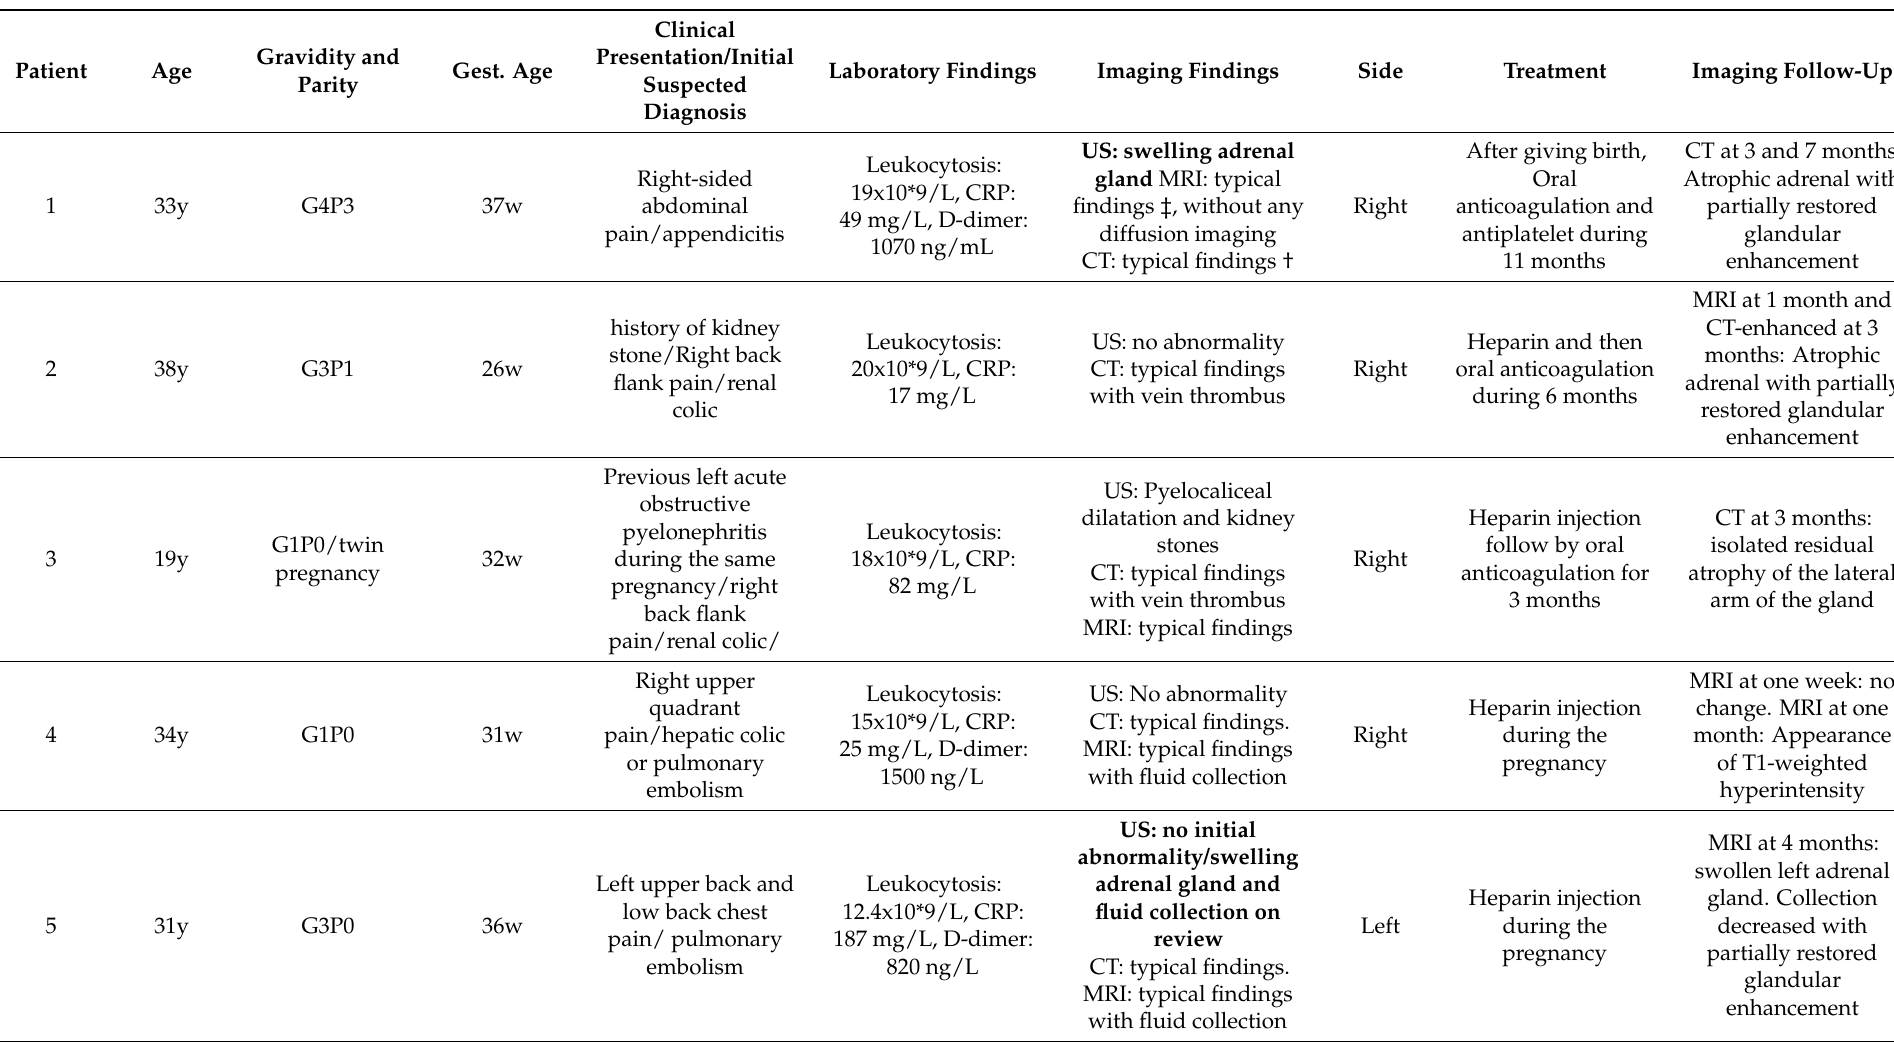
Table 1. Demographic data and